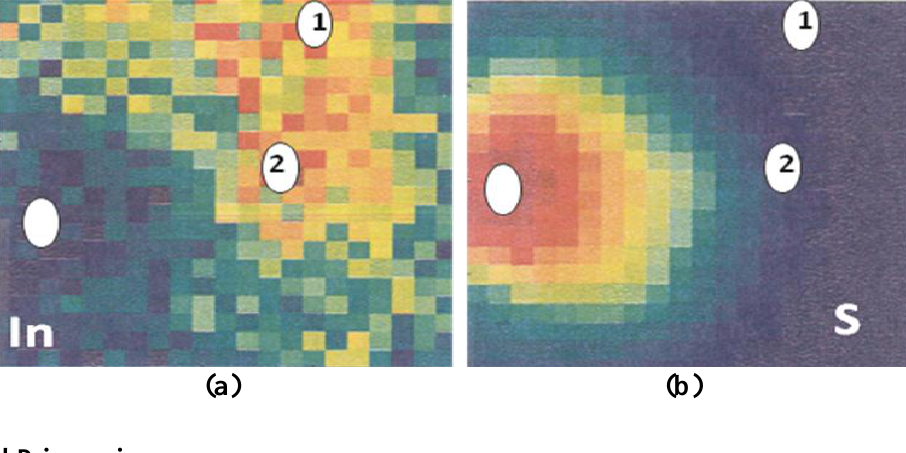
Figure 4. Topochemical map of a small area from a fragment of ore sample LS 5-180.6. Concentration of the selected element ( a ) In or ( b ) S: Red, maximum; blue, minimum. Points irradiated to collect In L -edge XANES spectra are marked by 3